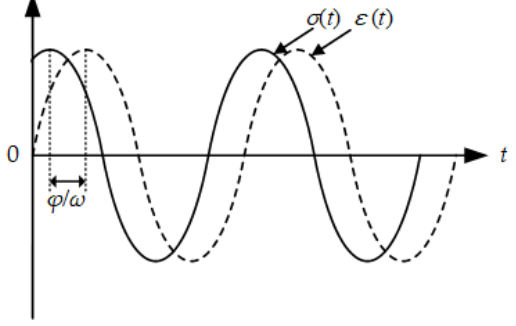
Figure 1. Curves of stress and strain in complex modulus test.